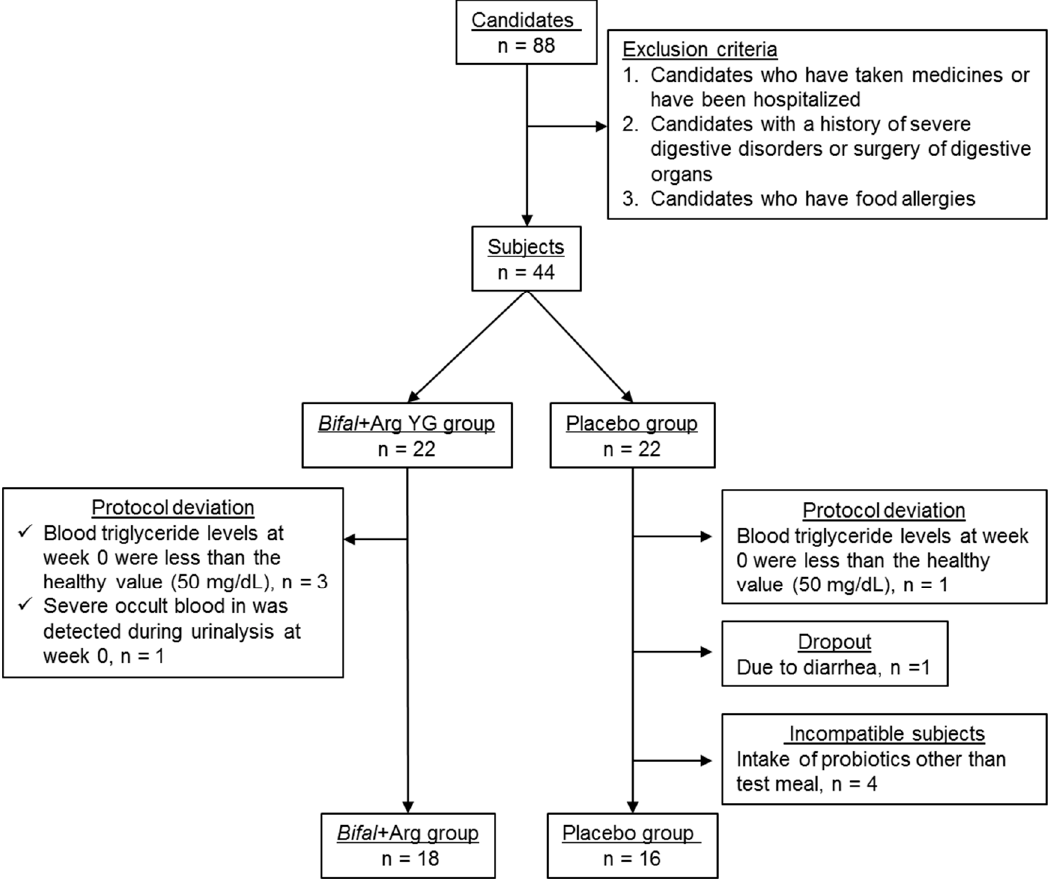
Figure 1. Method followed for subject selection.